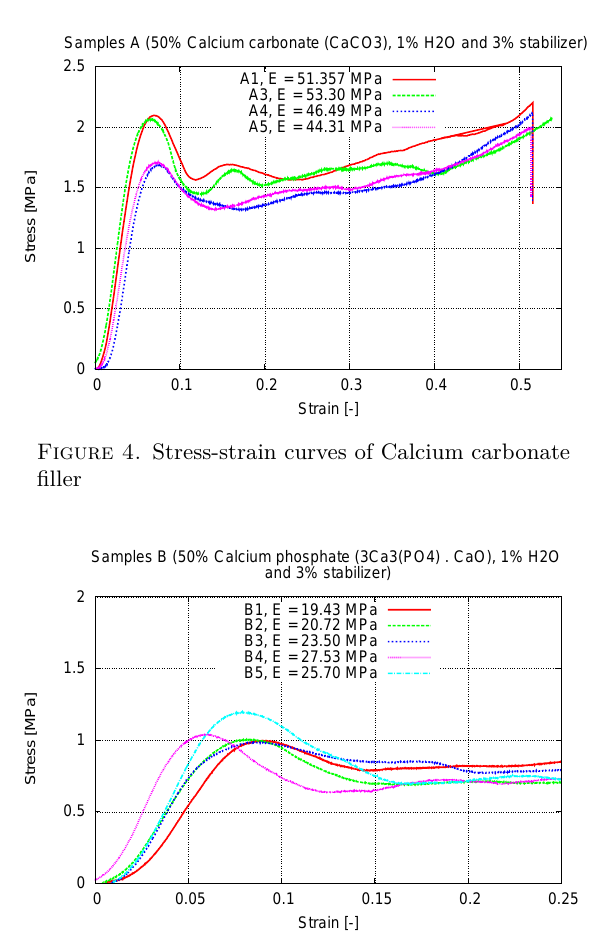
Figure 5. Stress-strain curves of Calcium phosphate filler